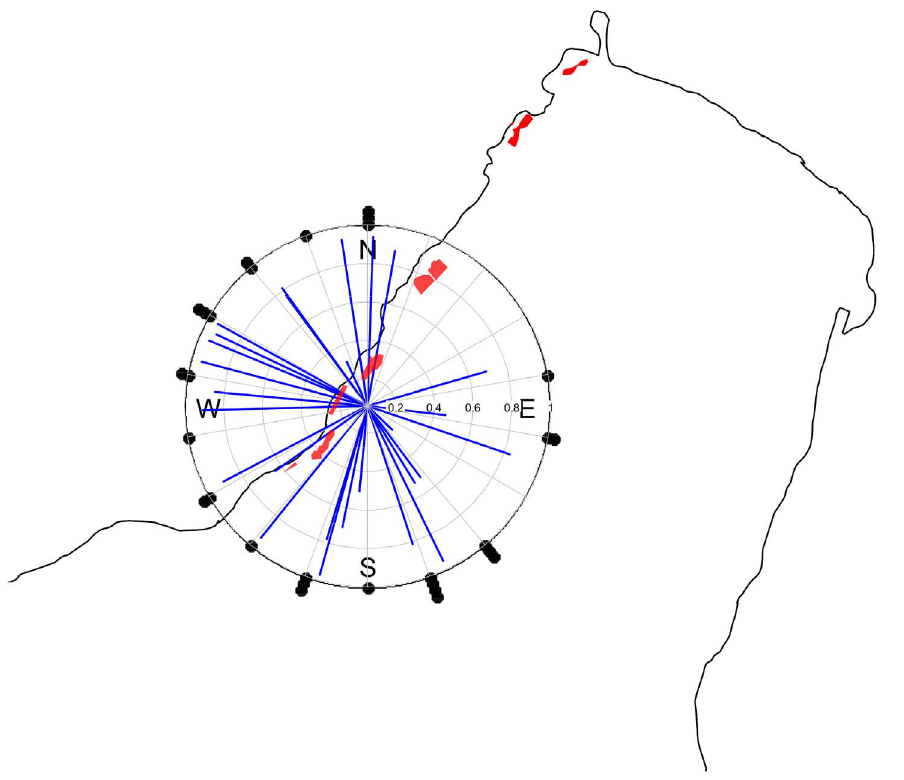
Figure 4. Mean bearings and directionality of Premnasbiaculeatus . Mean bearings and directionality (R c ) of 28 P. biaculeatus post-larvae, depicted by the direction and the length of the blue lines respectively. Red polygons represent nearby coral-reef